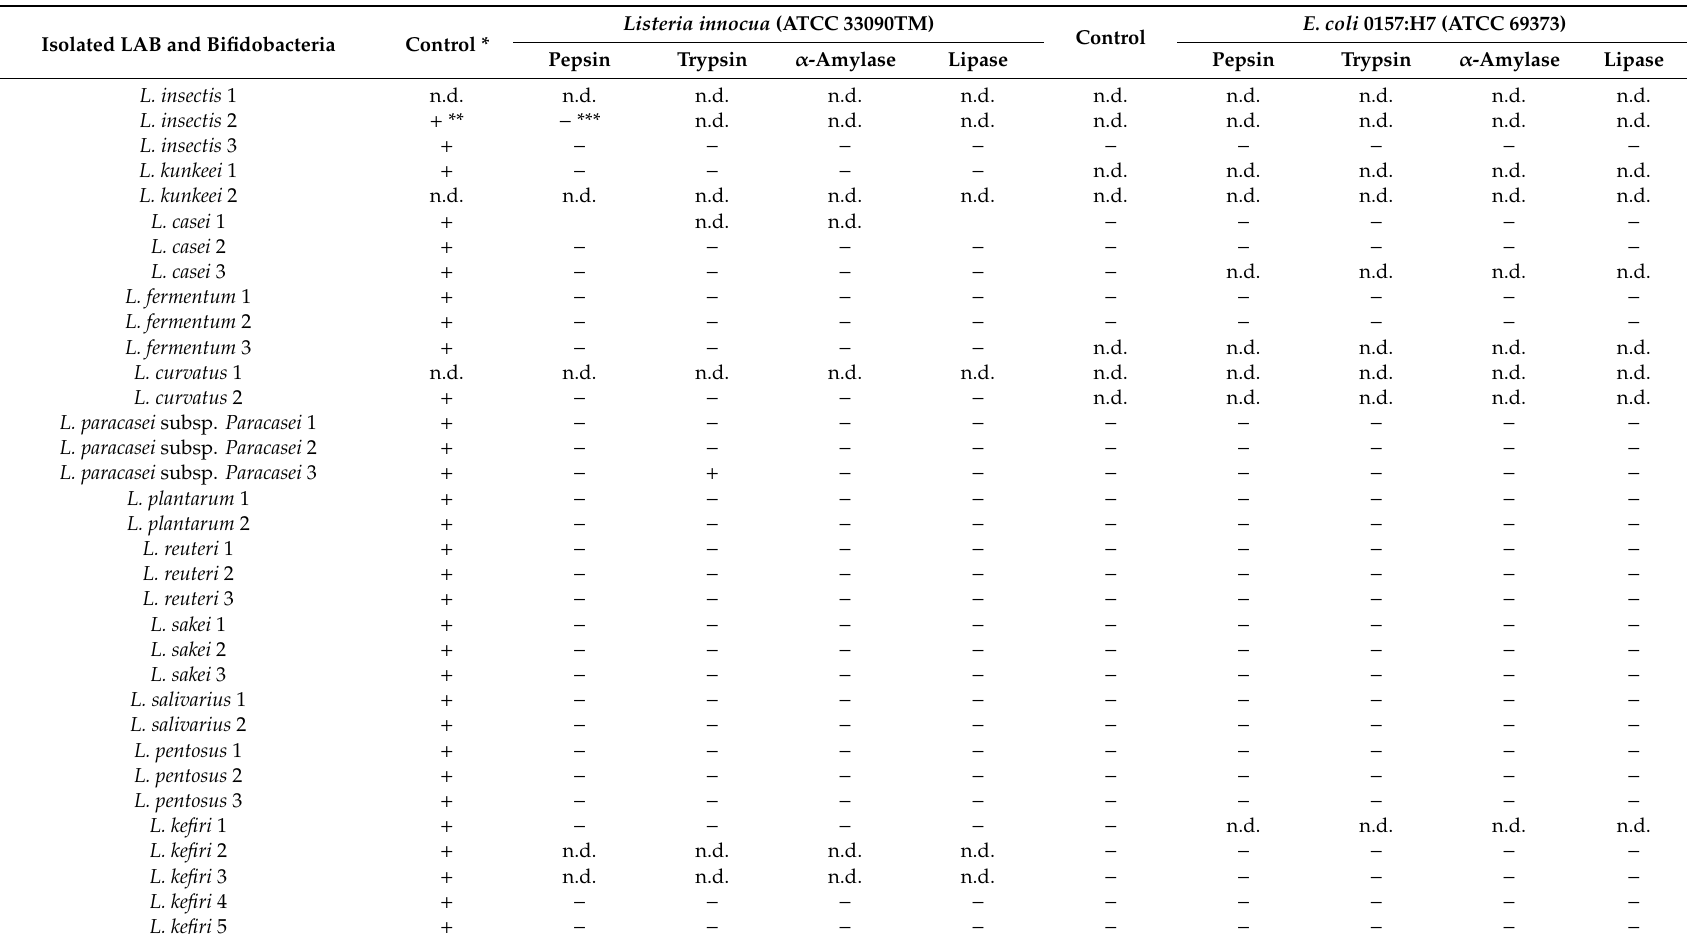
Table 4. The e ff ect of pepsin, trypsin, α -amylase and lipase treatment on the inhibitory activity of bacteriocin-like substances (BLS)produced by the LAB and Bifidobacterium isolates against indicators ( L. innocua (ATCC 33090TM) and E. coli 0157:H7 (ATCC 69373) strains). Isolated LAB and